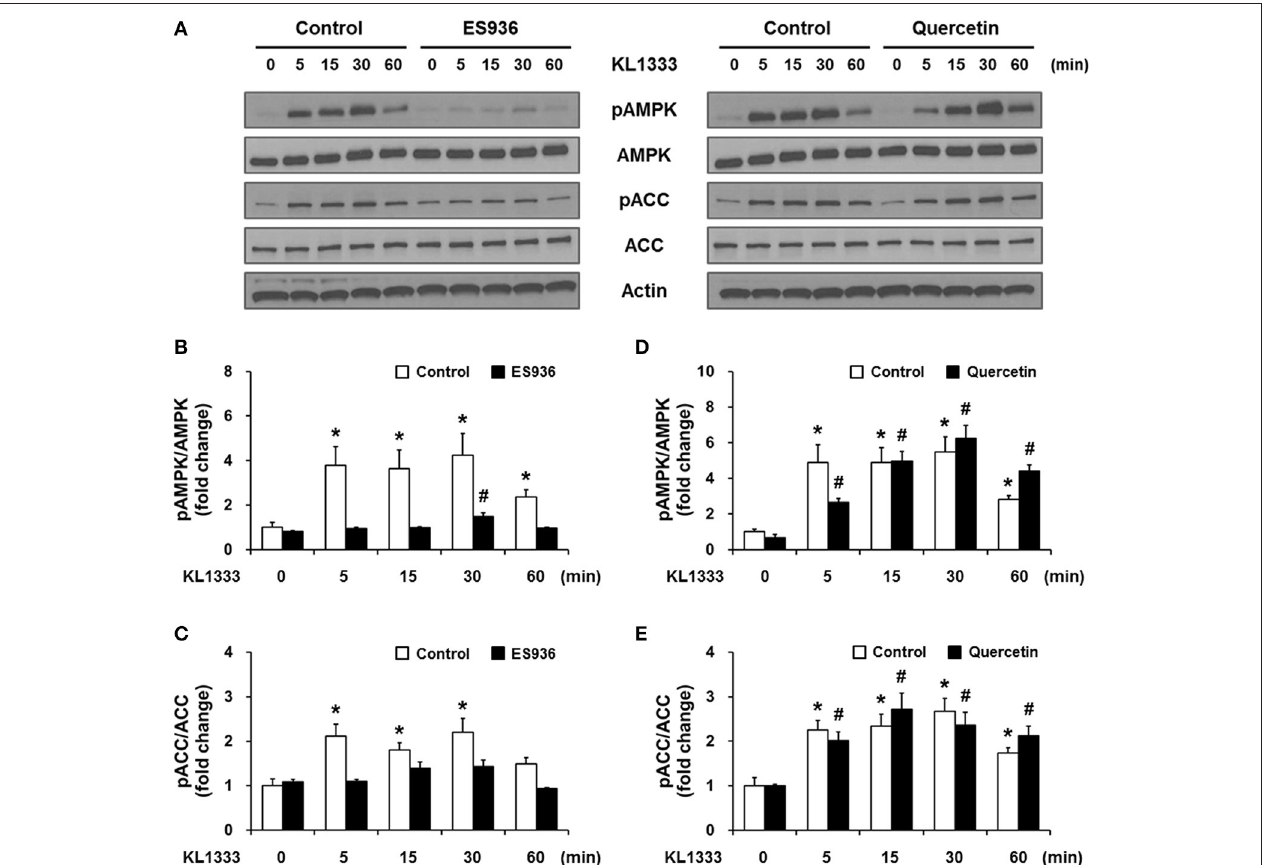
FIGURE 3 | KL1333 activates AMPK in a NQO1-dependent manner. (A) L6 myoblasts were pretreated with 250nM ES936 or 10 µ M quercetin for 1h, and then treated with 2 µ M KL1333 for the indicated times. The activity of AMPK was examined by Western blotting using the indicated antibodies. (B) Quantification of the pAMPK/AMPK ratio in ES936 and KL1333-treated cells. (C) Quantification of the pACC/ACC ratio in ES936 and KL1333-treated cells. (D) Quantification of the pAMPK/AMPK ratio in quercetin and KL1333-treated cells. (E) Quantification of the pACC/ACC ratio in quercetin and KL1333-treated cells. Each experiment was repeated three times. Error bars indicate ± SEM. * P < 0.05: significance with respect to the control group. # P < 0.05: significance with respect to the ES936- or quercetin-treated group.